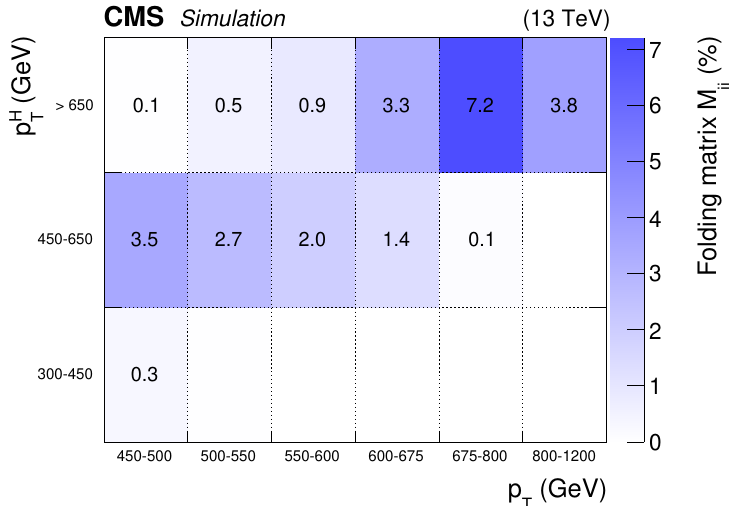
Figure 6 . The folding matrix M a percentage for an H(bb) event in p H